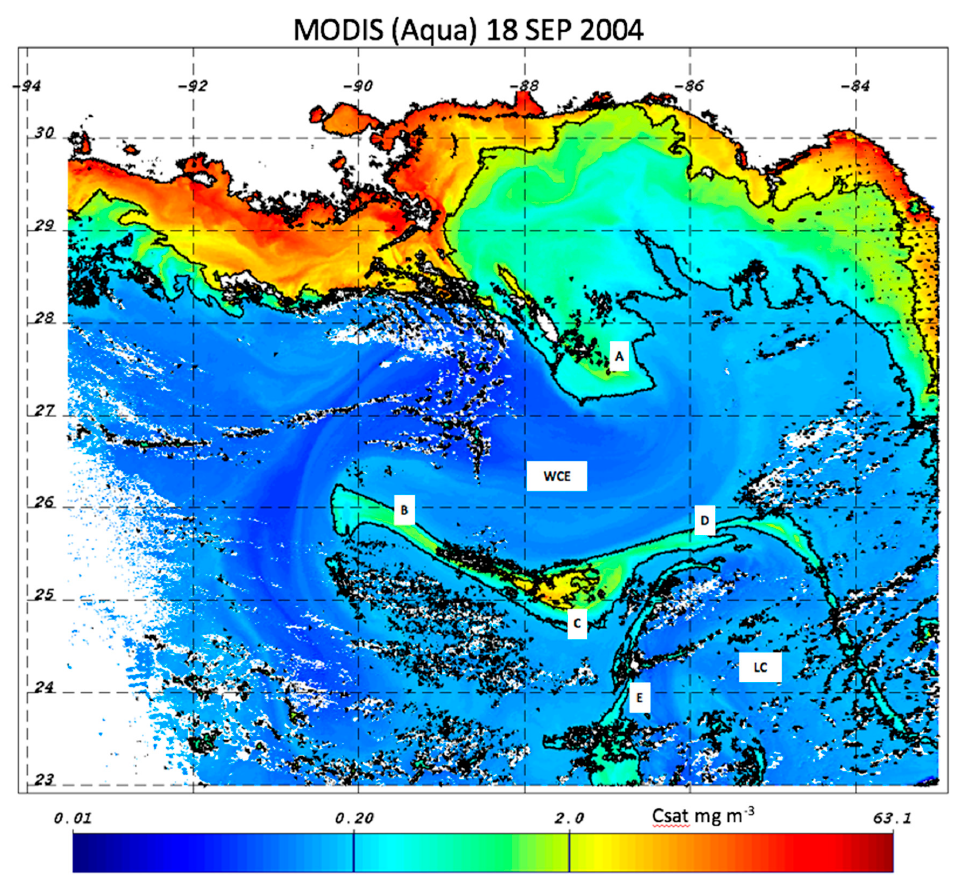
Figure 10. MODIS (Aqua) Csat product on 18 SEP 04. Lettered areas are referenced in the text. WCE indicates warm core eddy–anticyclonic circulation center, LC indicates Loop Current. Labeled areas are as follows: (A) large domain of right-sided TC SST reduction; (B) westward propagating cold filament; (C) CCE; (D) eastward cold filaments along LC edge; (E) area of likely LC-shelf (Campeche Bank) interaction.